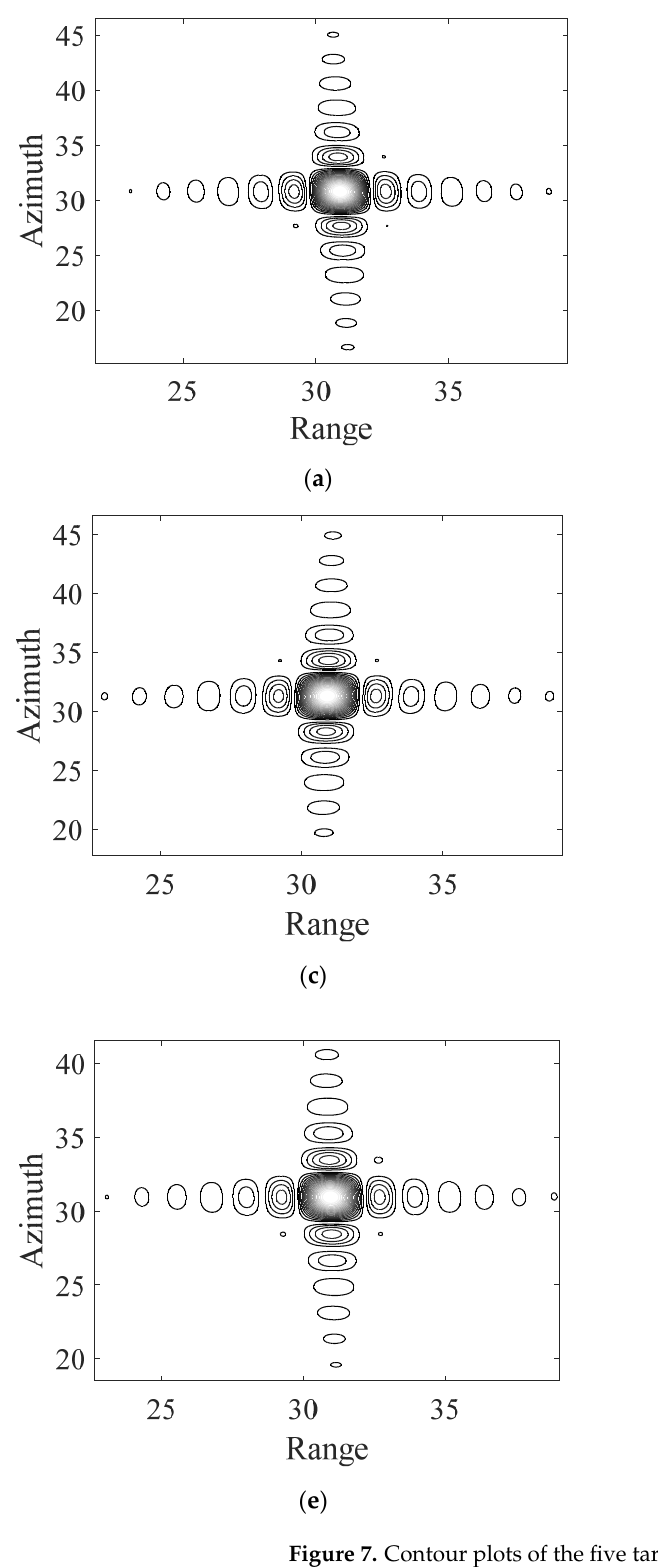
Figure 7. Contour plots of the five targets. ( a ) T1, ( b ) T2, ( c ) T3, ( d ) T4, and ( e ) T5. Table 4. Measured image quality parameters.